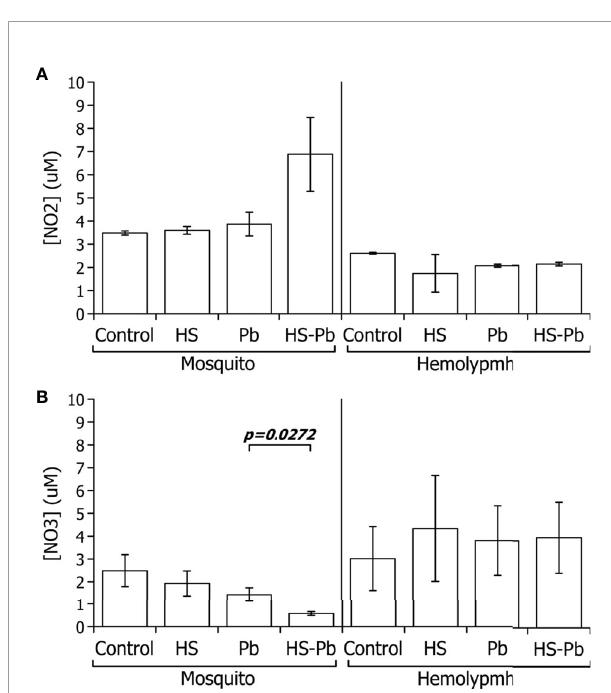
FIGURE 3 | Effect of heat shock on the nitric oxide derivatives of A. albimanus during a P. berghei infection. (A) NO − 2 production (B) NO − 3 production. Nitric oxide derivatives present in the hemolymph and body of A . albimanus female mosquitoes upon P. berghei (Pb) infection and 6 h post 30 min at 37°C heat-shock (heat shock) and the respective control samples. Data of three independent experiments were analyzed using Student ’ s t-test.